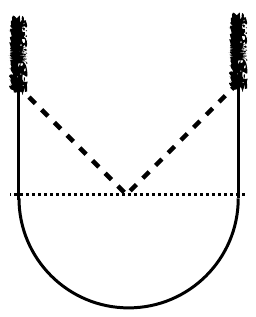
Figure 1 . Standard illustration of the Euclidean path integral preparing the charged thermo(cid:12)eld double state (2.14). The Euclidean part of the solution is below the dotted line; its boundary is an interval of length (cid:12)= 2. The fuzzy lines represent the timelike singularities of the subextremal Reissner-Nordstron black brane. We have omitted the transverse R d (cid:0) 1